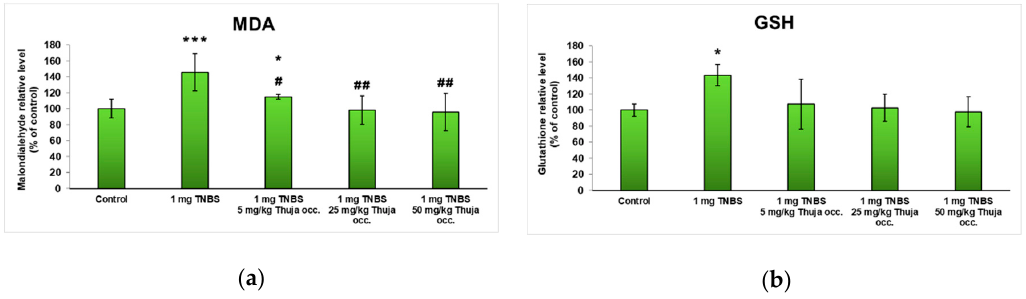
Figure 8. The level of malondialdehyde (MDA) ( a ) and reduced glutathione (GSH) ( b ) at the intestinal level in the experimental groups. Note: * p < 0.05 and *** p < 0.001 versus control; # p < 0.05 and ## p < 0.01 versus TNBS group.